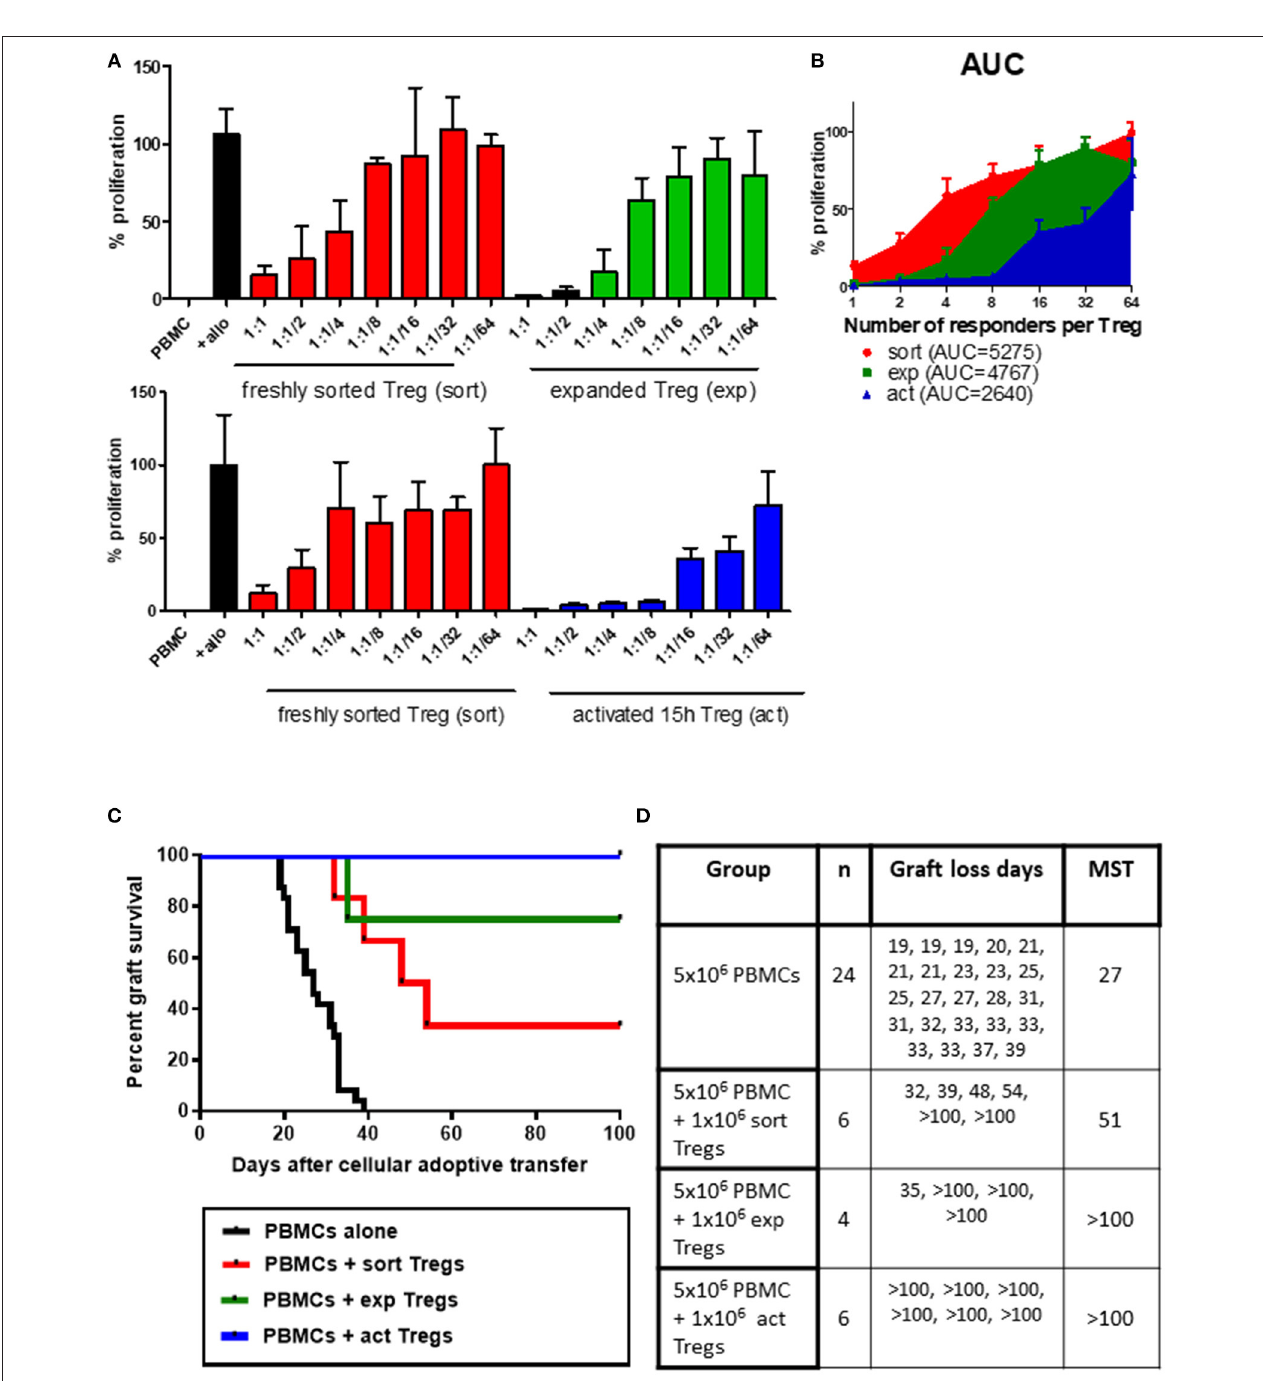
FIGURE 1 | Ex vivo expanded or transiently activated human Tregs have superior in vitro and in vivo suppressive capacity. (A) 5 × 10 4 PBMCs were incubated with 1 × 10 5 irradiated allogeneic PBMCs and co-cultured with a decreasing number of freshly isolated (sort) or ex vivo expanded (exp) (top panel) or transiently activated (act) (bottom panel) human Tregs. Ratios represent ratio of responder PBMC to Tregs. Data represented as percentage of proliferation of allogeneically-stimulated PBMC. (B) Area under curve for the frequency of proliferating responders in the presence of Tregs at different ratios. (C) Mice received a skin graft and 5 × 10 6 allogeneic PBMCs together with 1 × 10 6 freshly isolated, transiently activated (15h) or ex vivo expanded Tregs. Data are pooled from different skin/cell donor combinations. (D) Table representing data from B, MST—median survival time. p -values using the log-rank test for each comparison are shown.